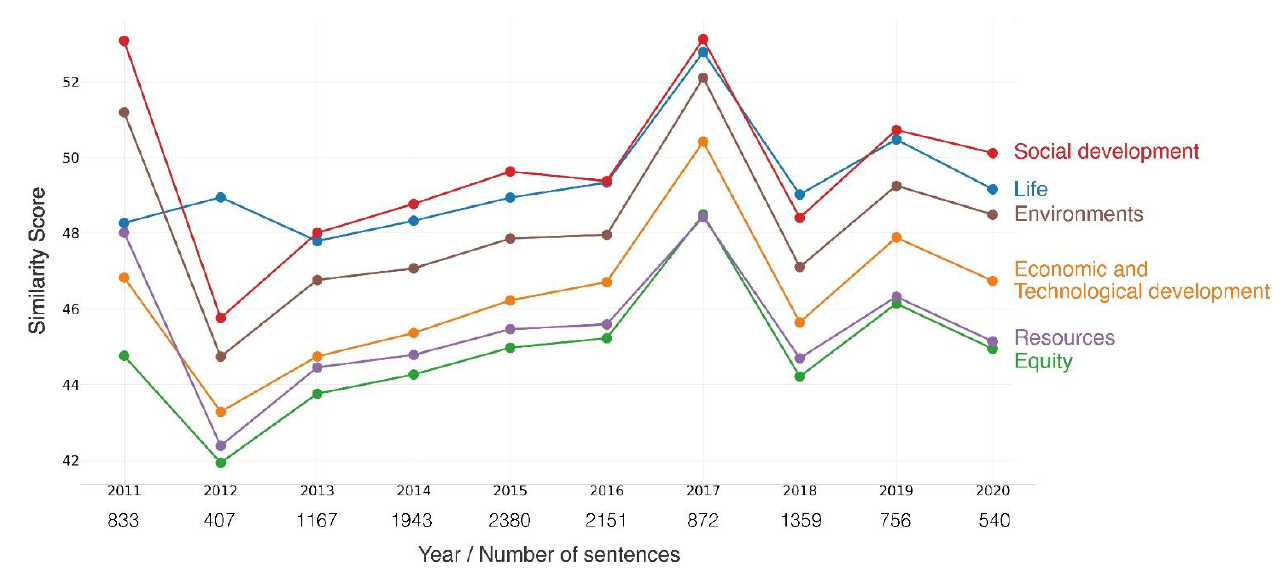
Figure 5. Thematic structure of sustainability reports: Nestle.